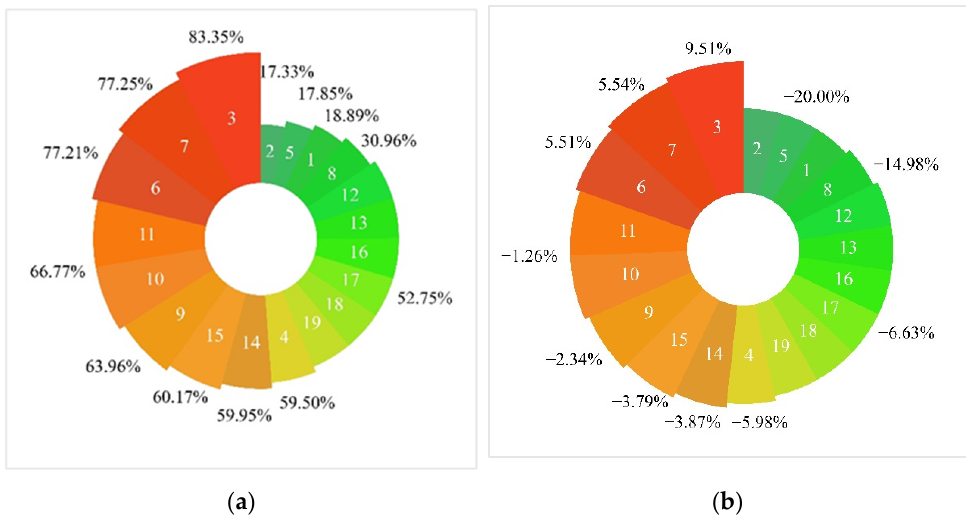
Figure 2. Change in the ESV based on the ITSP model in JMNNR compared to the project recommen- dation. ( a ) Upper limit of the change in ESV from the project recommendation. ( b ) Lower limit of the change in ESV from the project